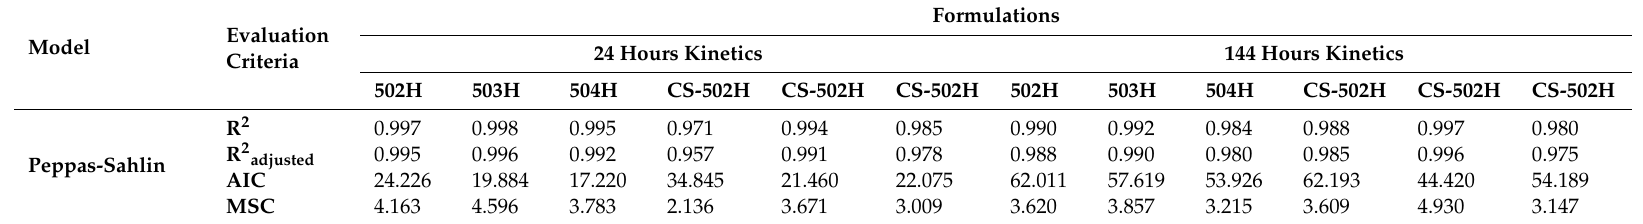
Table 6. Kinetic results for Peppas-Sahlin Model.